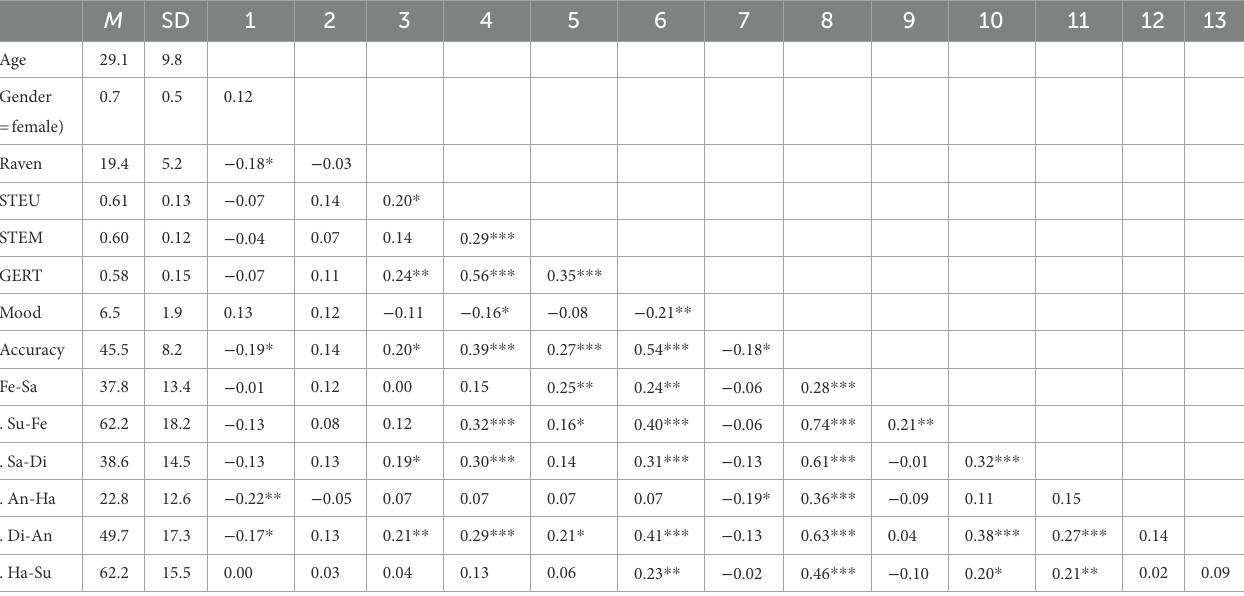
TABLE 1 Descriptive statistics and correlations for the variables in the